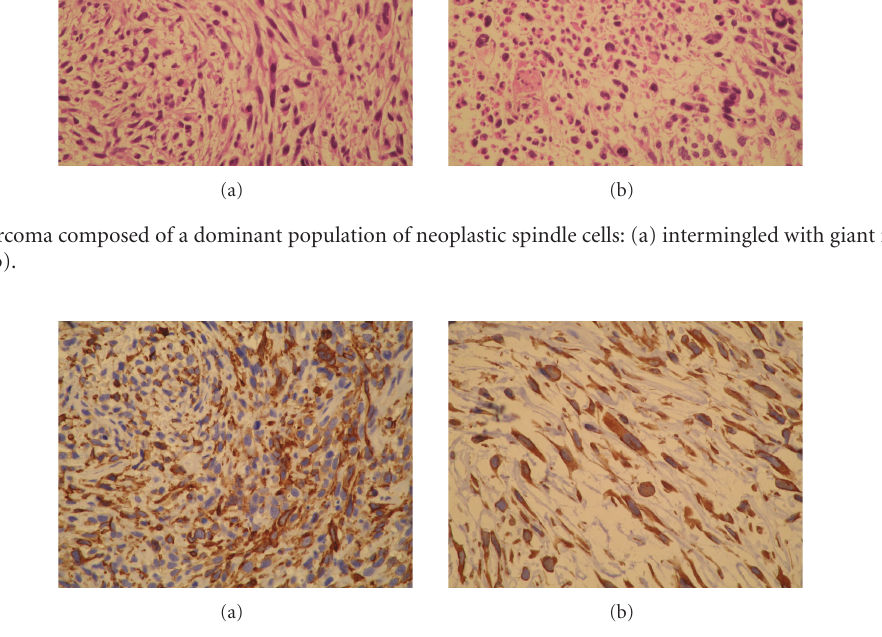
exhibited no staining for S-100, cytokeratins, and CD117 (c-